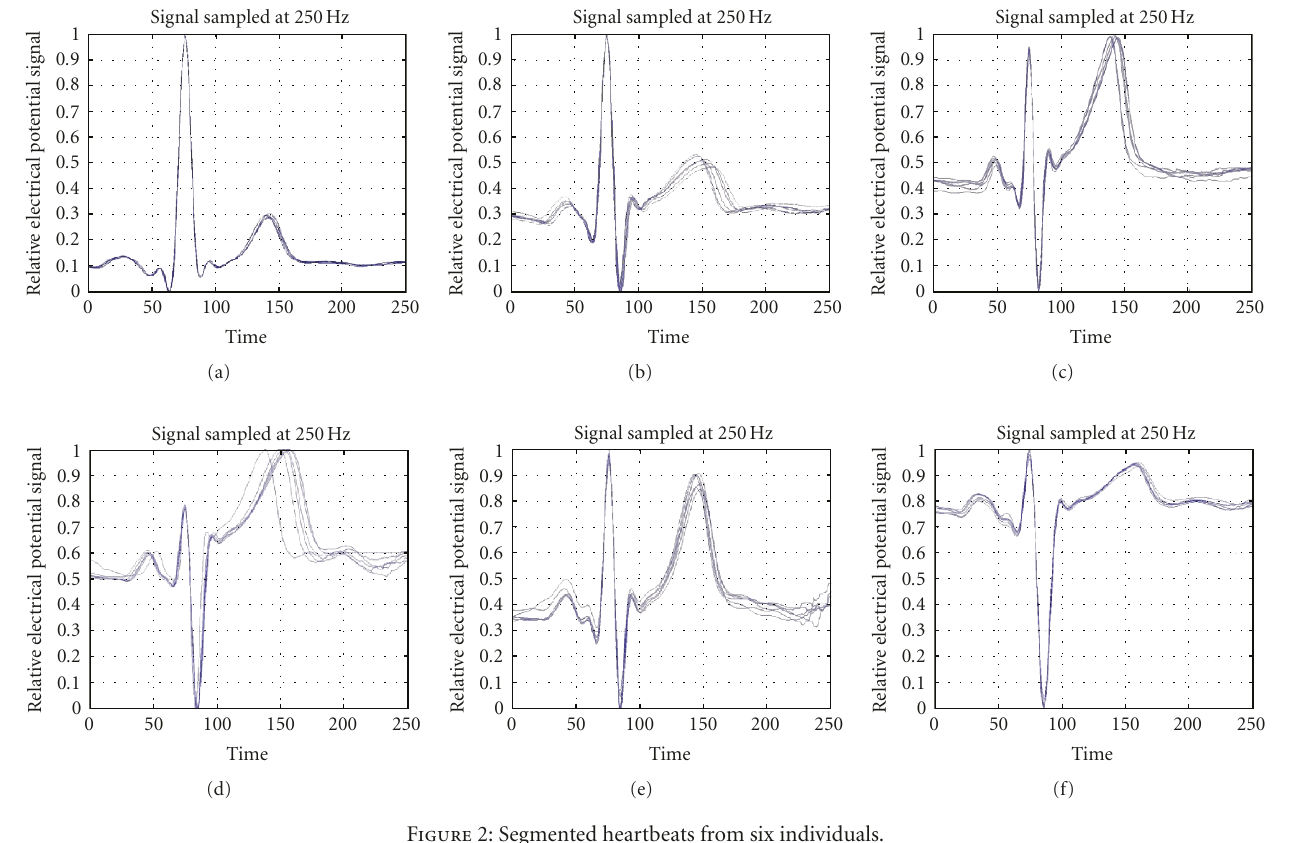
Figure 2: Segmented heartbeats from six individuals.